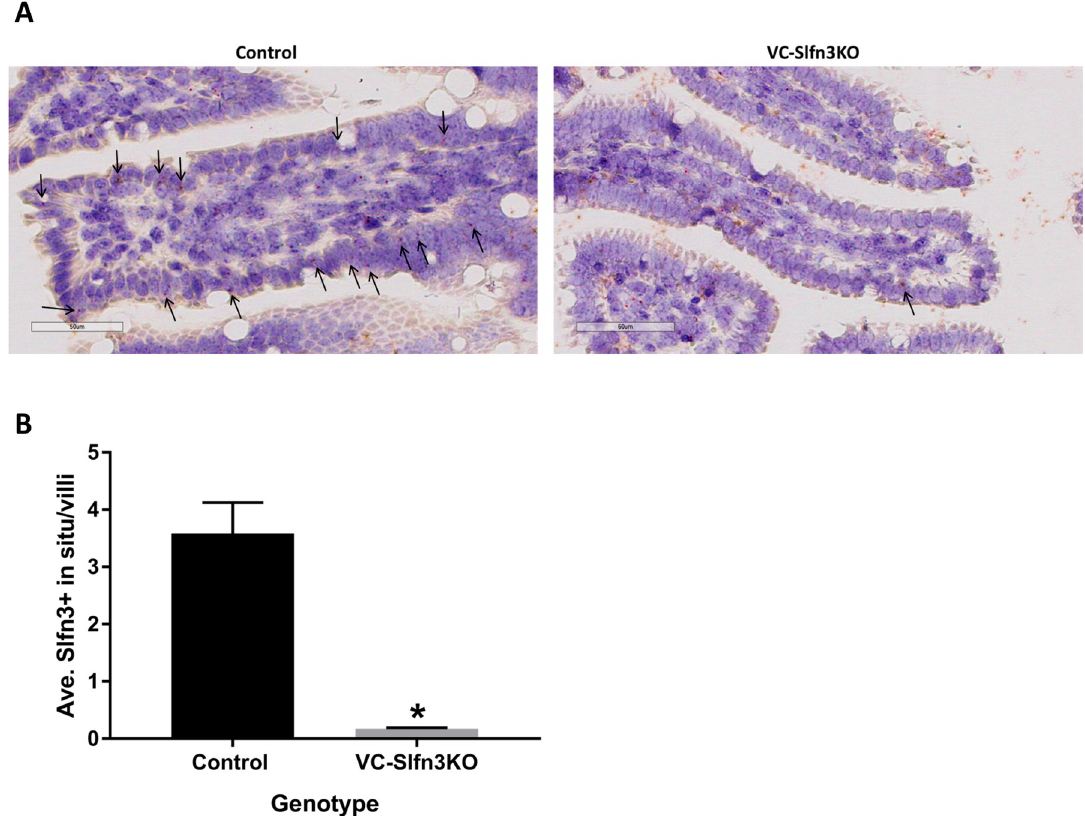
Fig 2. Confirmation of Slfn3 knockout in the Vil-Cre intestinal epithelial specific cells. RNA in situ hybridization experiments were performed by Advanced Cell Diagnostics, Inc. using RNAscope technology. (A) Images of Ctrl and VC-Slfn3KO villi with arrows indicating Slfn3+ intestinal epithelial cells. (B) Bar graph quantification of the average number intestinal epithelial cells that were Slfn3 + per villi (n = 3 mice/group, average of 22 villi per sample, � p � 0.05). https://doi.org/10.1371/journal.pone.0259195.g002 had such a marked change in RNA expression in both male and female VC-Slfn3KO mice, we evaluated SI protein expression by flow cytometry in EpCam + epithelial cells, excluding CD3 + immune cells (which also express Slfn3 and SI). SI protein expression changed based on sex and intestinal region. Enterocytes from male VC-Slfn3KO mice did not achieve a statistically